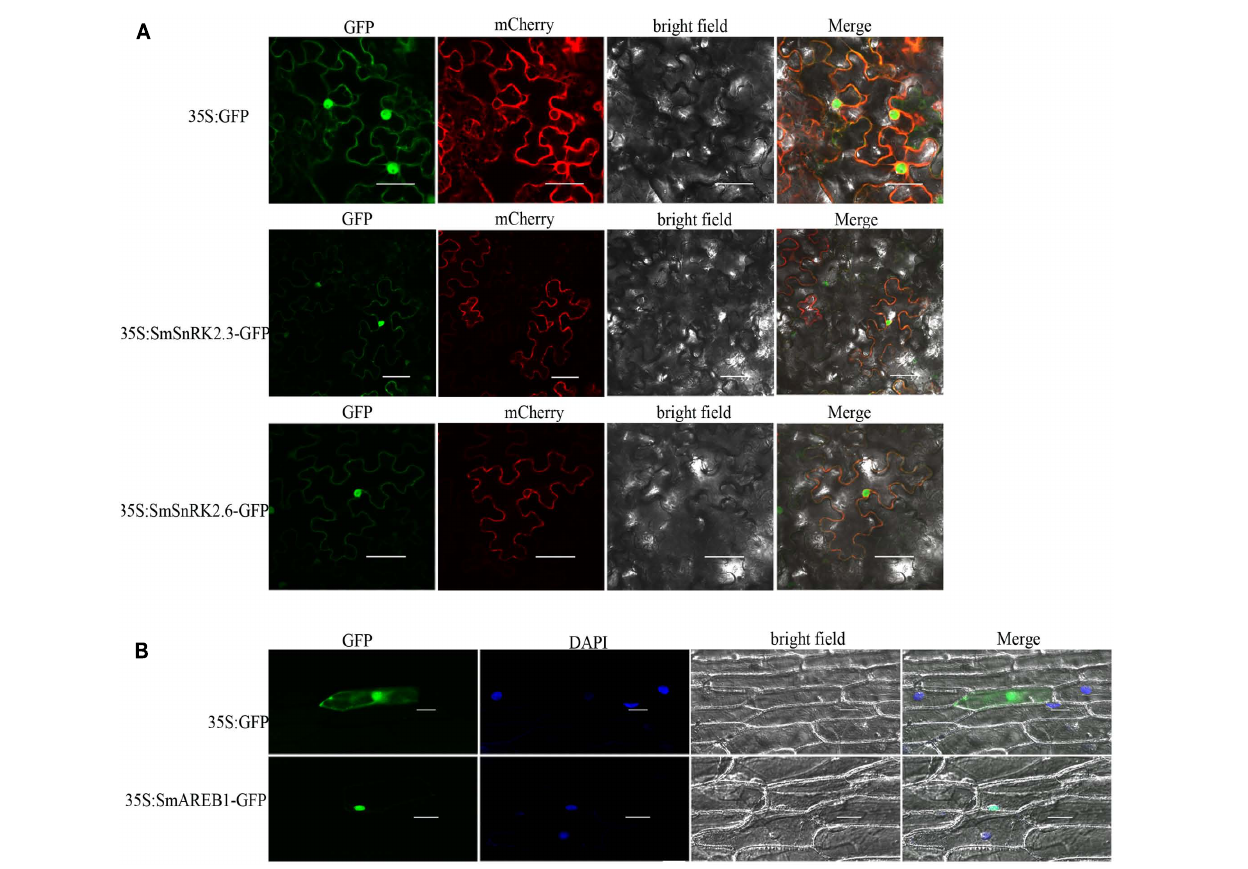
FIGURE 4 | Subcellular localization of SmSnRK2.3 , SmSnRK2.6 , and SmAREB1. (A) Subcellular localization of SmSnRK2.3 and SmSnRK2.6 in leaf epidermal cells of tobacco. GFP: green fluorescence; mCherry: red fluorescence of plasma membrane marker; Merge: merge of bright field and relevant fluorescences. Scale bar = 50 µ m. (B) Subcellular localization of SmAREB1 in onion epidermal cells. GFP, green fluorescence; DAPI, fluorescence of DAPI nuclear dye; Merge, merge of bright field, GFP, and DAPI. Independent of (A) or (B) , fluorescences of the empty vector pCAMBIA1301 were used as control. Scale bar = 50 µ